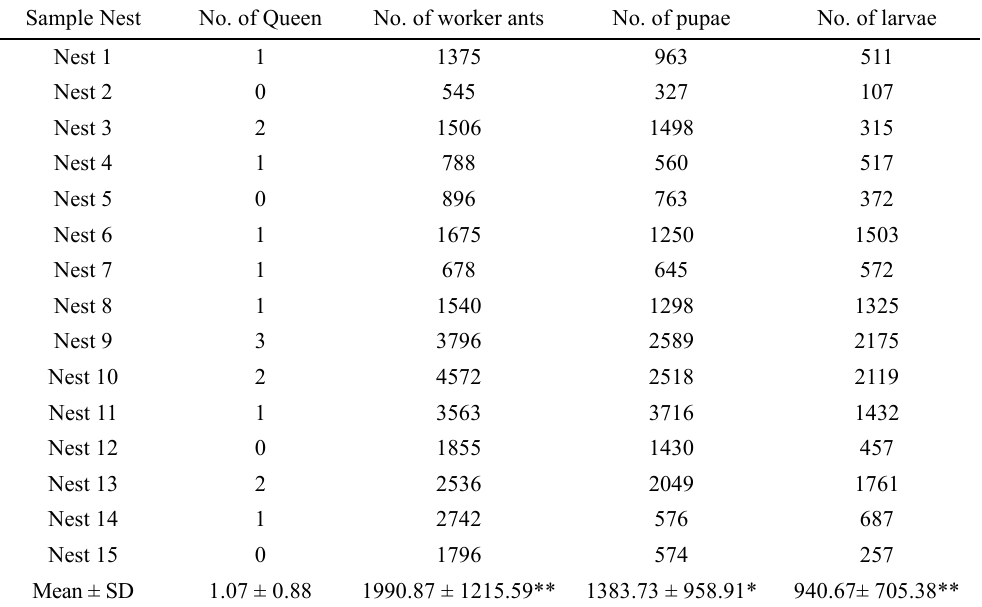
Table 4 . Details of different castes of O. smaragdina present per nest. The result is expressed as Mean ± SD, n = 15, *p ≤ 0.05 and **p ≤ 0.01 compared to the presence or absence of the queen. (The significance value was taken from Pearson correlation analysis shown in Table 5).